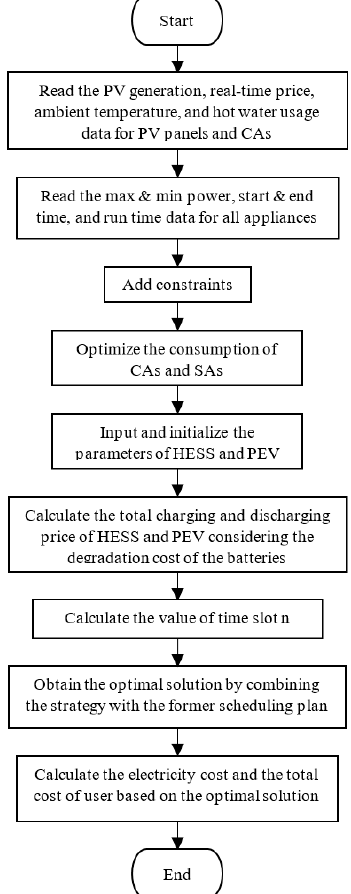
Figure 4. Flow chart of the optimization algorithm for HEMS.